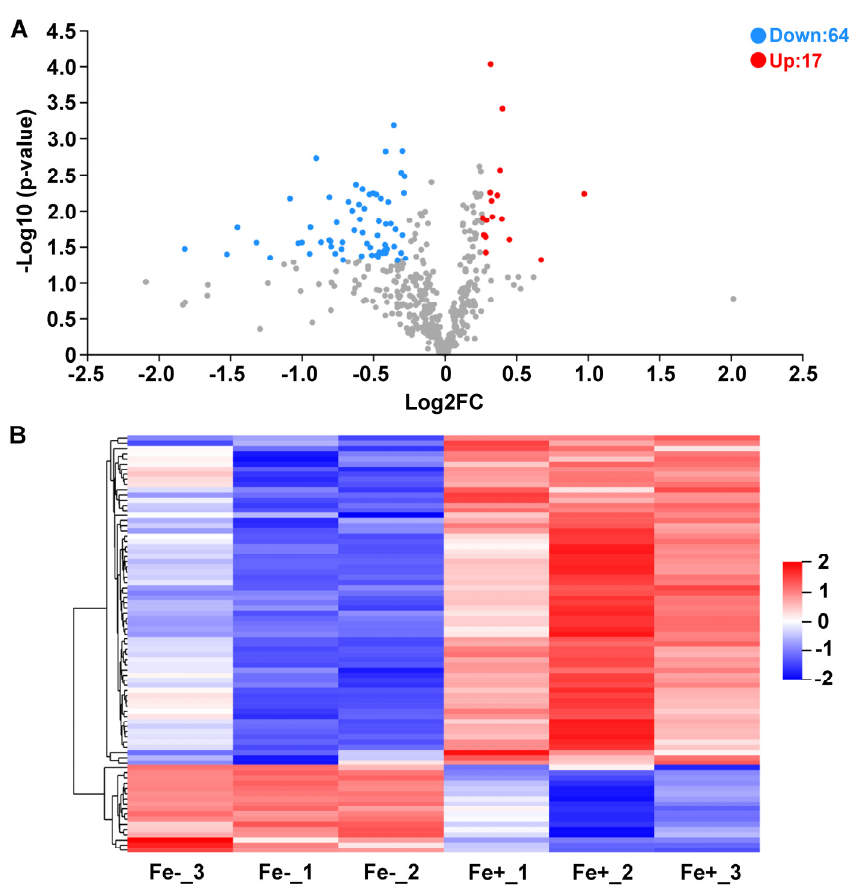
Figure 4. Differentially expressed proteins (DAPs) between Fe-sufficient (Fe+) and Fe-deficient (Fe − ) groups. ( A ) Volcano plot of DAPs. Red dot represents up-regulated proteins and blue dot represents down-regulated proteins. ( B ) Hierarchically-clustered heatmap diagram of DAPs. Each row represents one significant protein. Fe-_1, Fe-_2, Fe-_3: three biological replicates of Fe − group; Fe+_1, Fe+_2, Fe+_3: three biological replicates of Fe+ group.